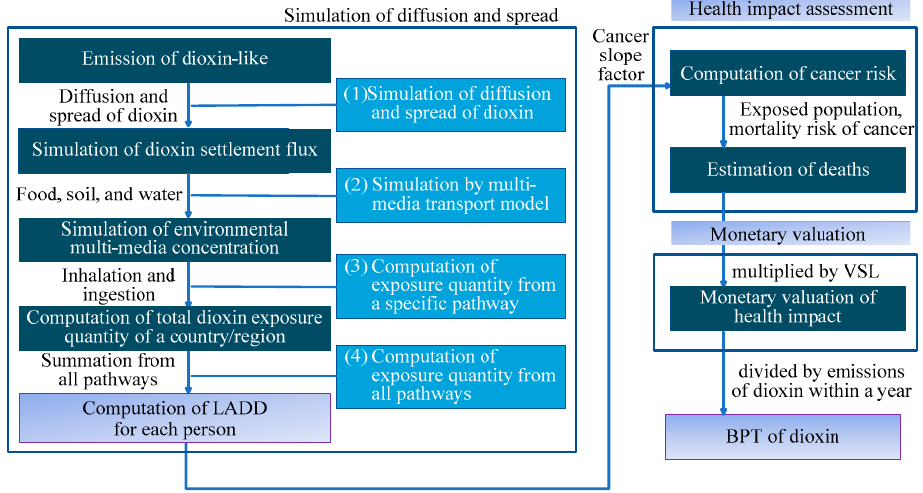
Figure 1. The impact pathway approach framework for assessing the monetary BPT of dioxin emissions.